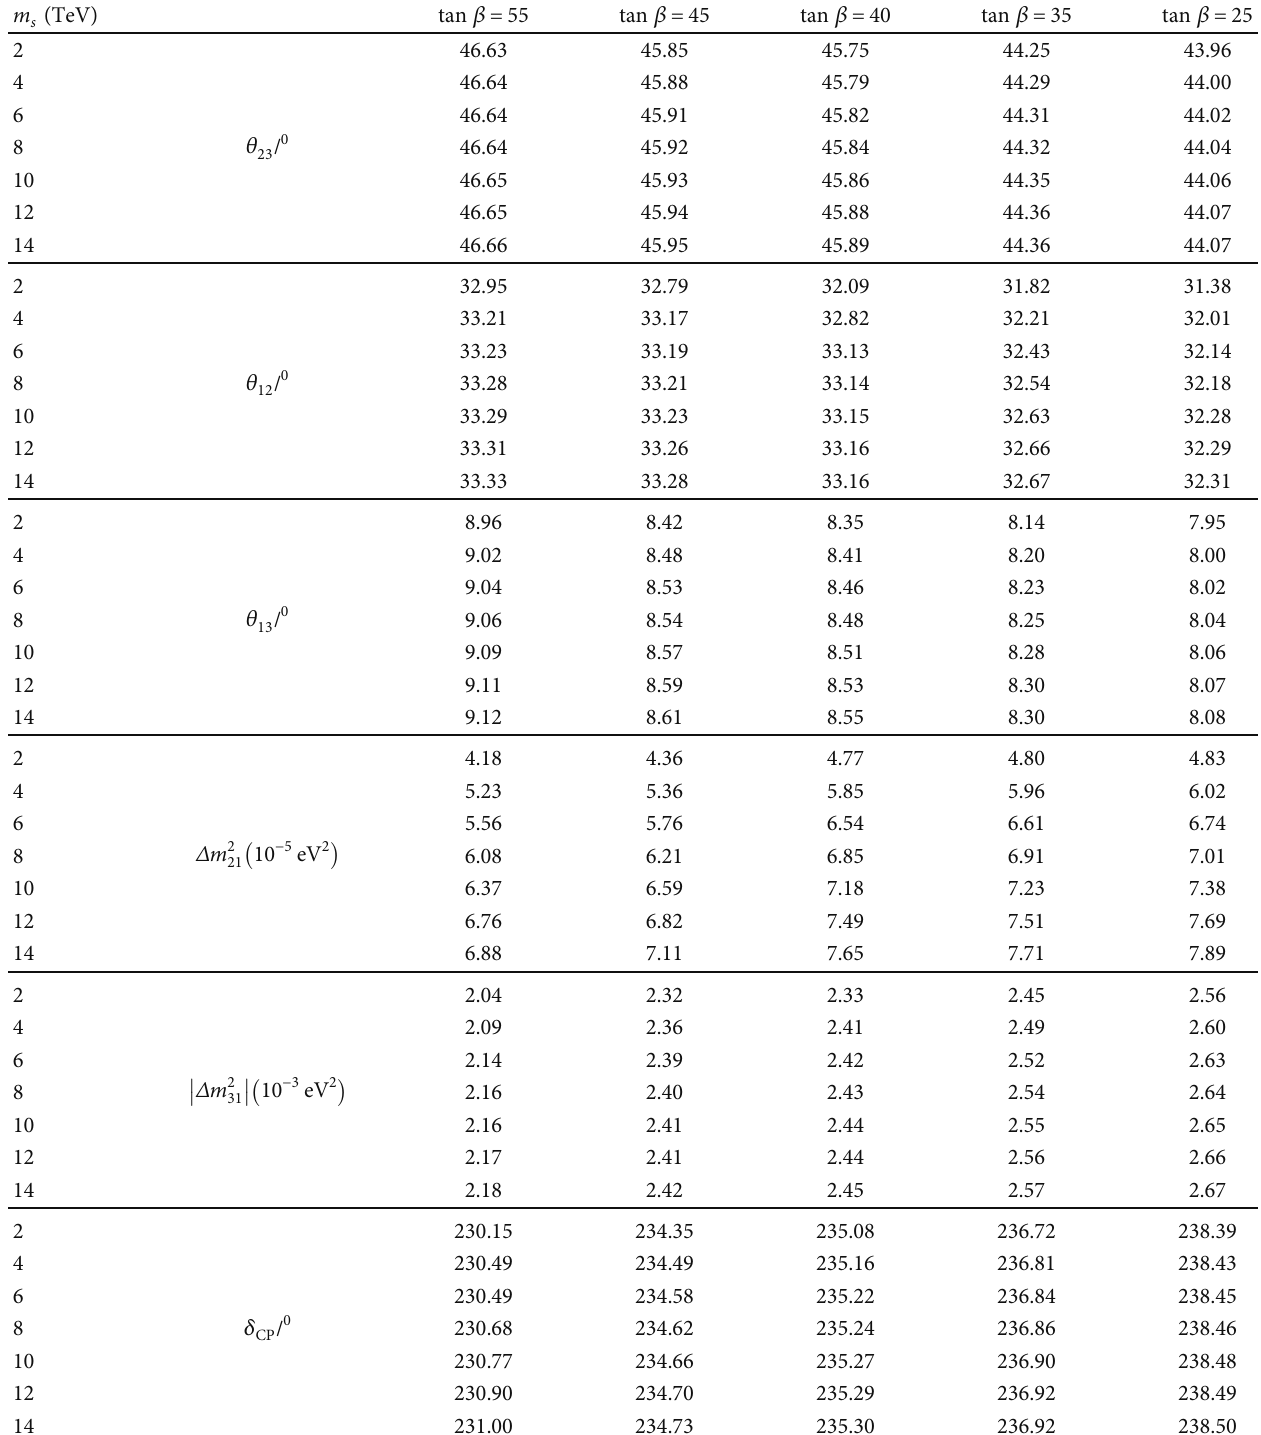
and tan β for NH case ( M = 10 14 GeV). s R